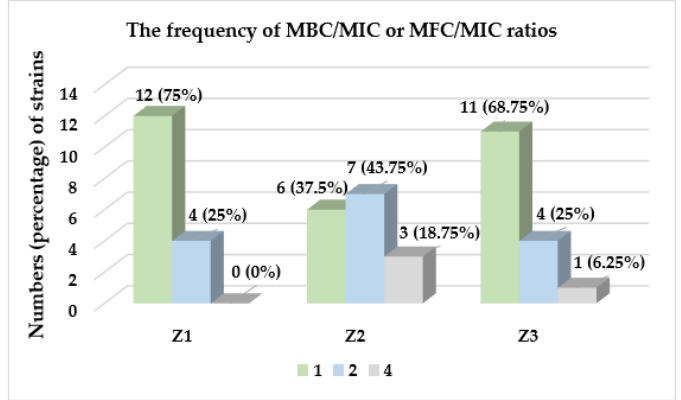
Figure 2. The frequency of occurrence of particular MBC/MIC or MFC/MIC ratios of Z. bungeana extracts against the reference strains of bacteria and fungi used in the study. Table 4. The activity data of Z. bungeana extracts expressed as TAA (Total Antibacterial Activity or Total Antifungal Activity) [mL/g] against the reference strains of bacteria and